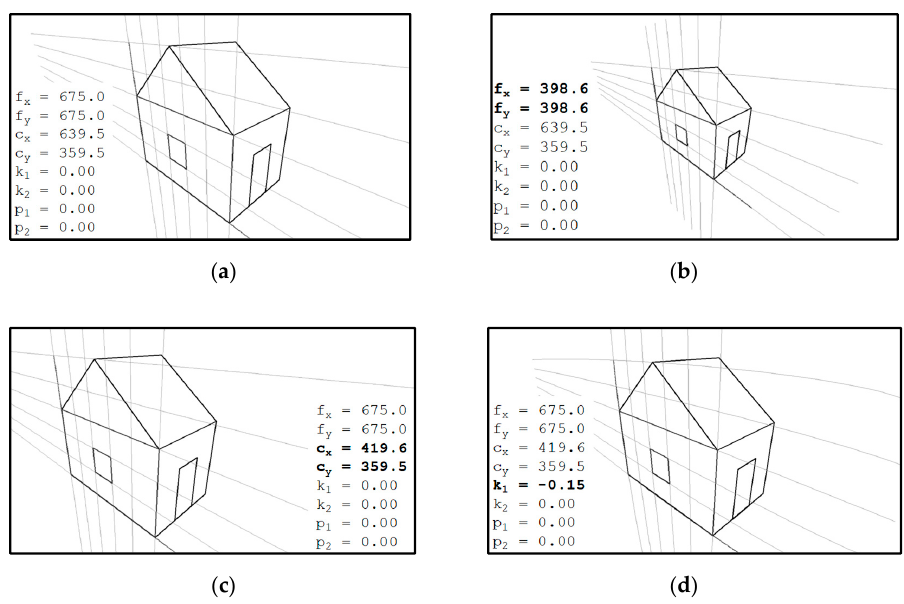
Figure 2. Effects of selected intrinsic parameters. Intrinsic parameters represent the optical properties of a camera. ( a ) house projected in an image. ( b ) Wider angle of view induced by a smaller focal length. ( c ) Translation induced by a biased principal point. ( d ) Distortion induced by a negative coefficient k 1.